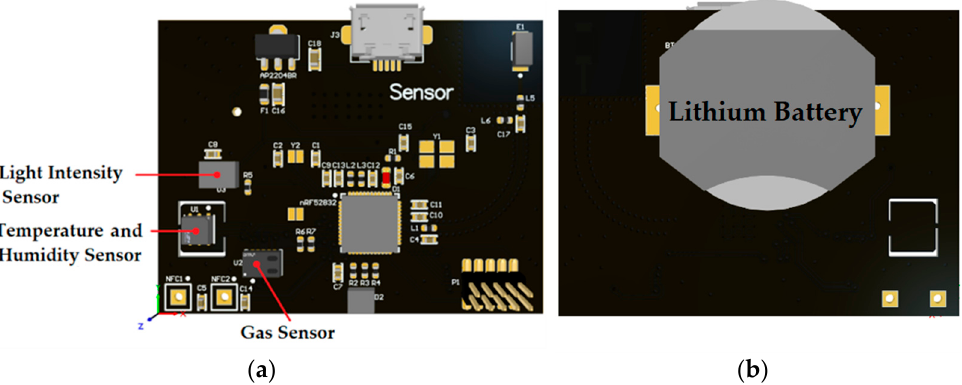
Figure 12. Three-dimensional visualization of a building sensor designed by CBRTI Sp. z o.o. Research and Development Center: ( a ) front of the building sensor, ( b ) rear of the building sensor.